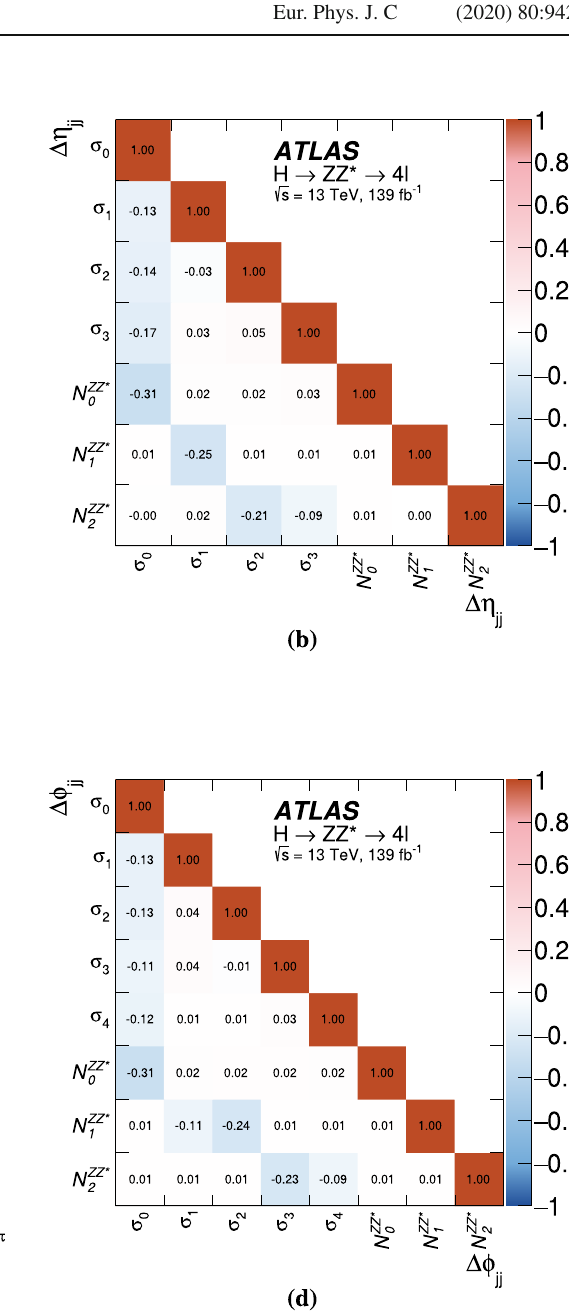
jets that pass the jet selection requirements. Finally, the corresponding correlation matrices between the measured cross sections and the Z Z ∗ background normalisation factors are provided ( b and d